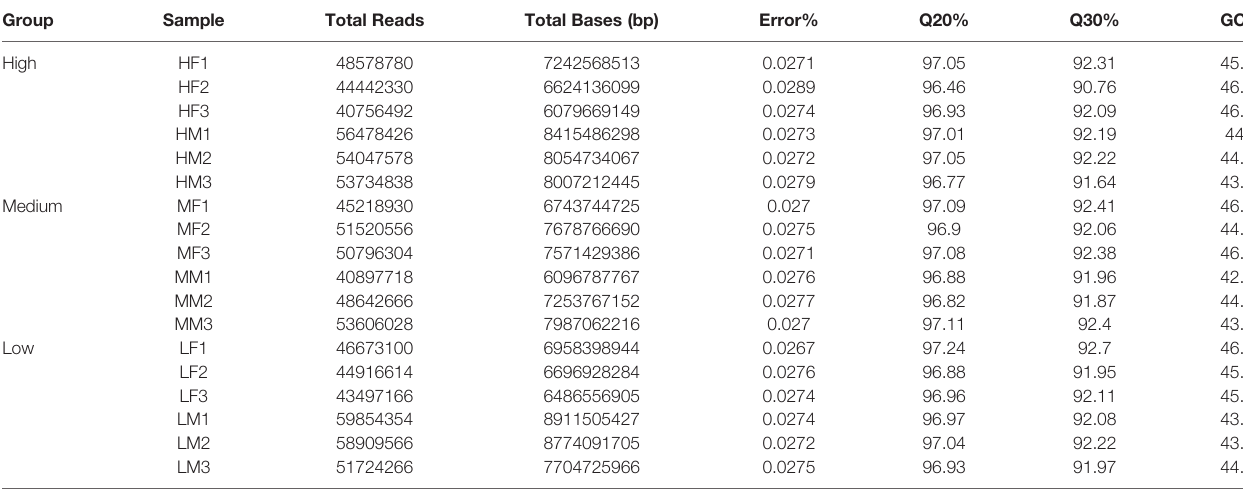
TABLE 1 | Quality assessment of the sequencing clean data. Group